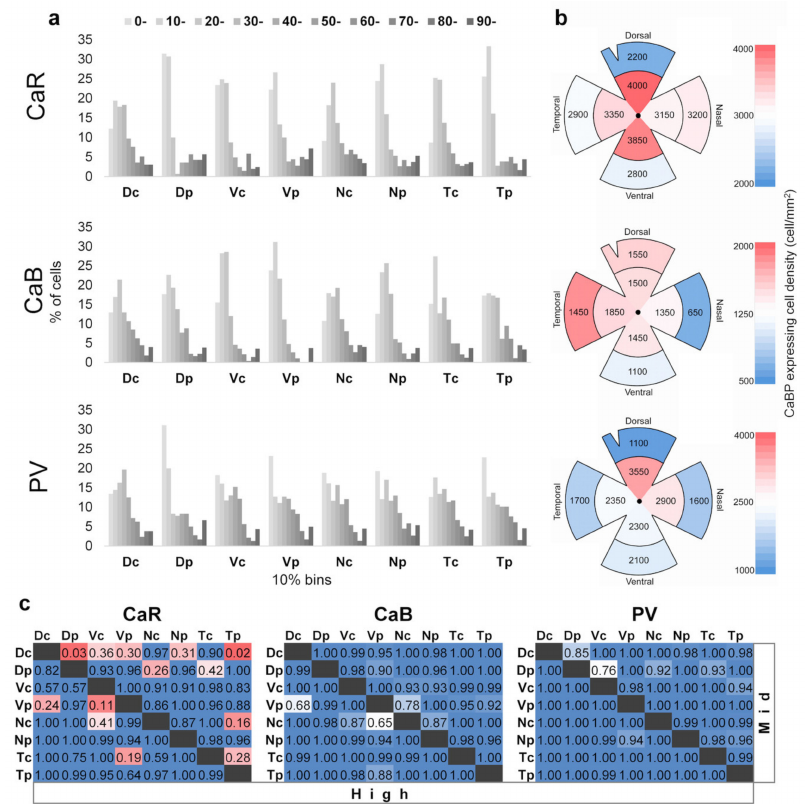
Figure 2. Topographical di ff erences of CaBP expression in the mouse retina. ( a ) Expression intensity histograms. Individual bars show percentage of cells from the whole data subset and from the marked central or peripheral quadrant parts, those belonging to the 10% bin size of absolute expression intensity for each. A higher number of cells express lower levels (0%–30%) of CaR, CaB, and PV than at middle- (30%–60%) and high (60%–100%) levels in the dorsal (D), ventral (V), nasal (N), temporal (T), central (c), and peripheral (p) areas of the mouse retina (n = 5; 1727 RGCs, for variance see Figure S4). ( b ) The distribution density of CaBP expressing cells can be seen color coded. Higher densities are shown in red, average in white, and low values in blue, all three CaBPs are visualized using separate color scales to emphasize di ff erences in the distribution within each CaBP group. In all cases a central-peripheral di ff erence can be observed, showing higher densities towards the center. ( c ) Matrices show significance levels of a pairwise area-specific comparison in the expressional levels of CaBPs for medium (30%–60%) and high expression level (60% + ) cells. Red outlines mark p -values that represent significant di ff erences ( p < 0.05). pink color represents close-to-significant p -values, while white and blue background suggests a no-to-small di ff